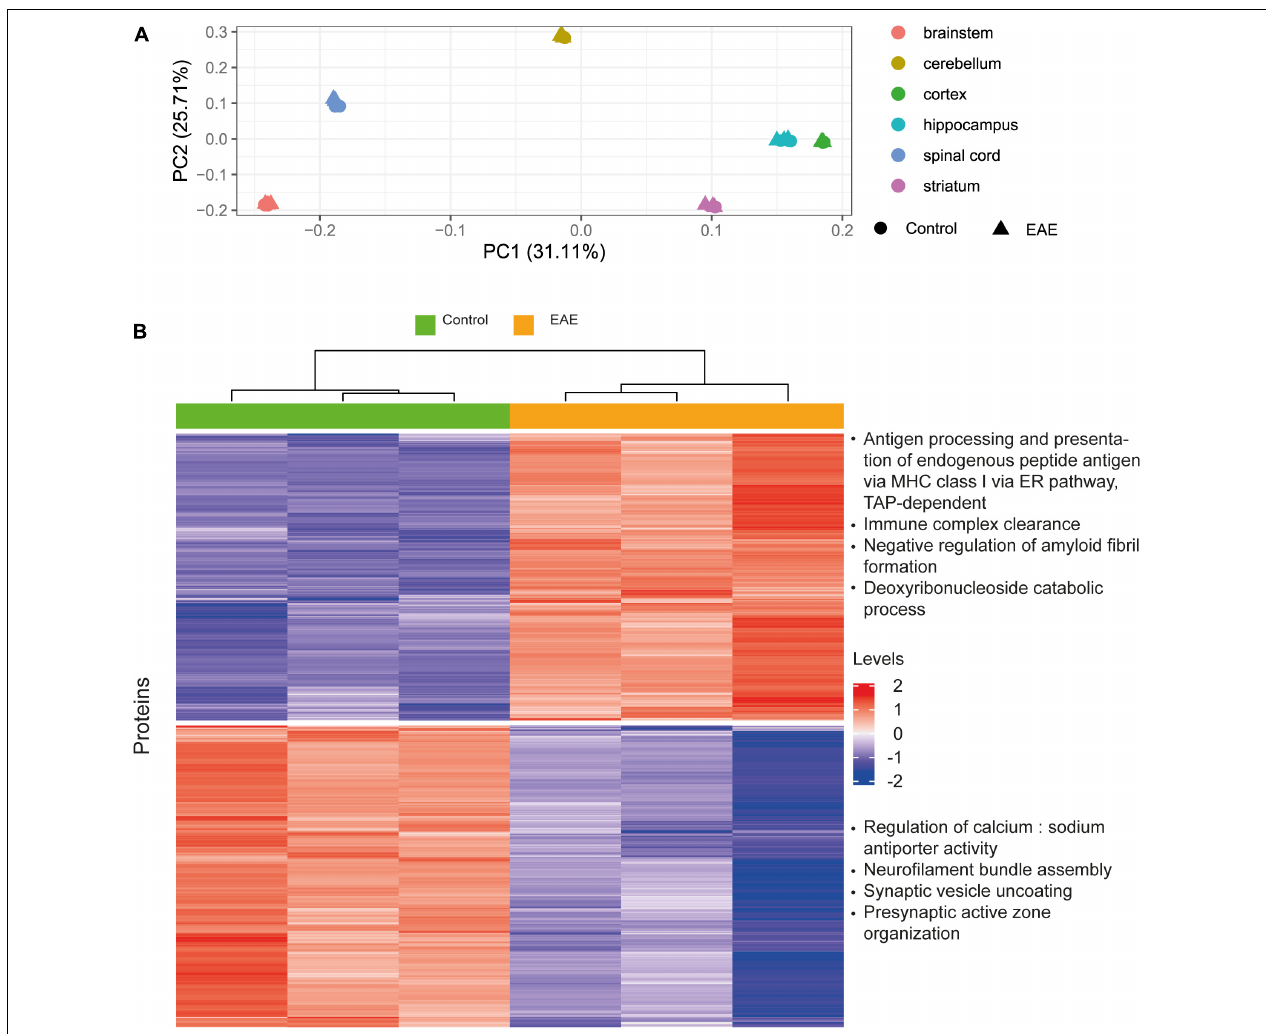
FIGURE 8 | Case study for differential protein concentrations analysis across brain regions and states. (A) Principal component analysis performed on the Molecular Atlas protein concentrations estimated from Hasan et al. (2019) data. (B) Hierarchical clustering of proteins with differential concentrations in EAE spinal cord samples compared to healthy spinal cord (based on 3128 proteins). Top four enriched GO biological process terms are shown on the right of the corresponding cluster. Levels refer to row-scaled centered median-normalized Molecular Atlas